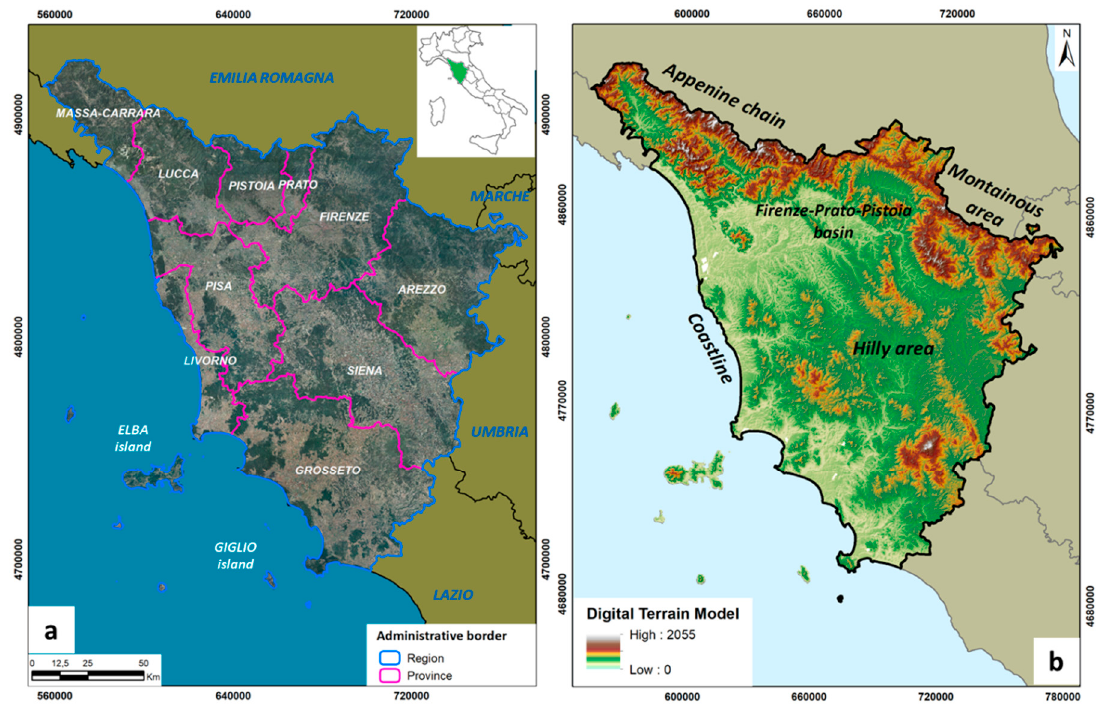
Figure 1. Geographical (a) and geomorphological (b) framework of Tuscany Region. The background of inset (a) is an aerial orthophoto referred to year 2012. The Digital Terrain Model (b) has a resolution of inset ( a ) is an aerial orthophoto referred to year 2012. The Digital Terrain Model ( b ) has a resolution of 10 m. of 10